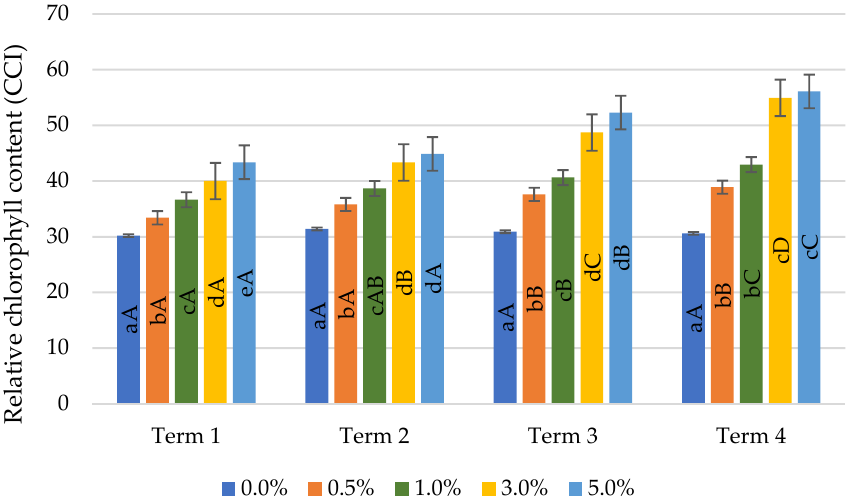
Figure 3. Effect of quercetin derivative concentrations and terms of measurement on relative chlorophyll content (Term 1—first day after the first treatment, Term 2—seventh days after the first treatment, Term 3—first day after the second treatment, Term 4—seventh days after the second treatment). Capital letters indicate significant differences between the means at measurement terms for each quercetin derivative concentrations, lowercase letters indicate significant differences between the means at respective measurement terms according to ANOVA (followed by Tukey’s HSD test, p = 0.05).